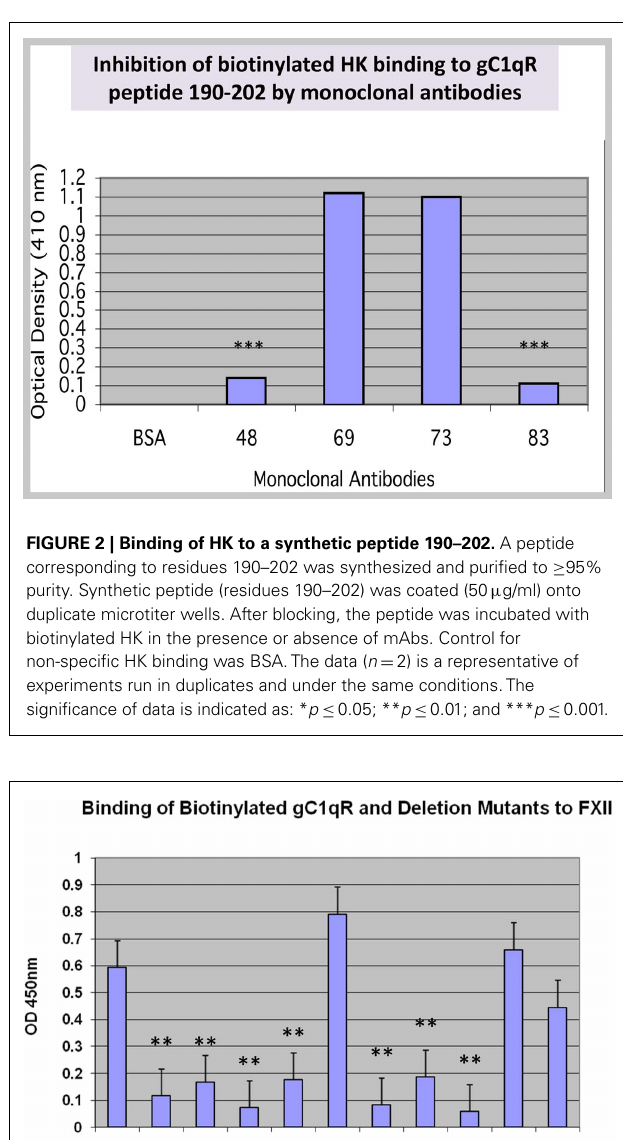
carefully selected,not only by reason of a likely functional role,but tal structure (Jiang et al.,1999;Ghebrehiwet et al.,2002). The